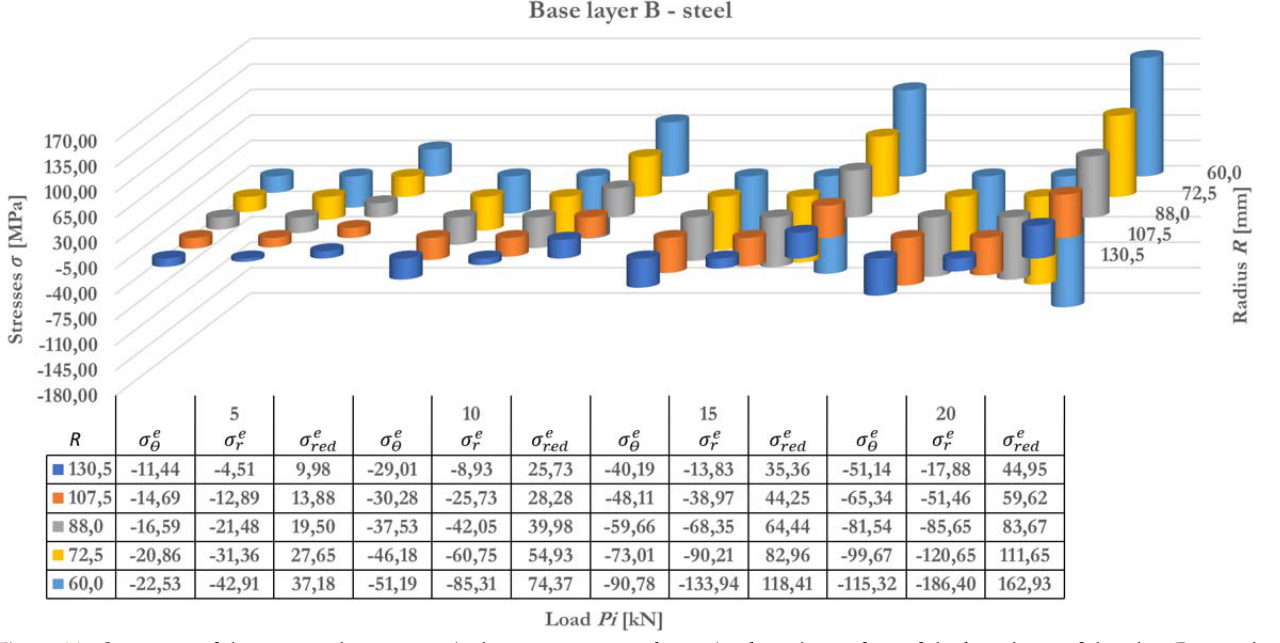
Figure 11: Summary of the stress values, respectively:   ,  r  red determined on the surface of the base layer of the plate B – steel, in this case, the load was applied from the side of the steel